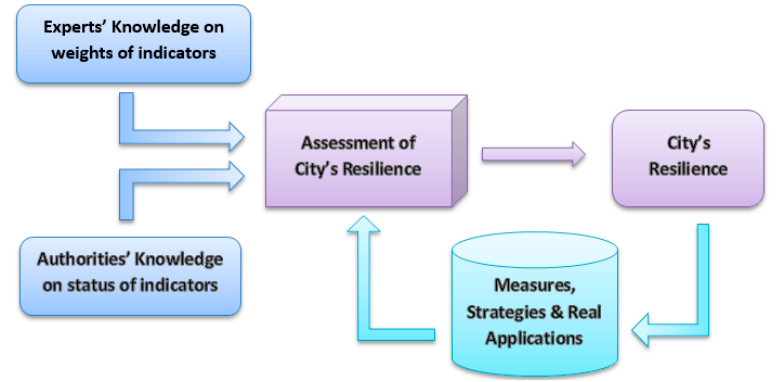
Figure 11. Integrating PEARL KB with FRI while incorporating experts’ and stakeholders’